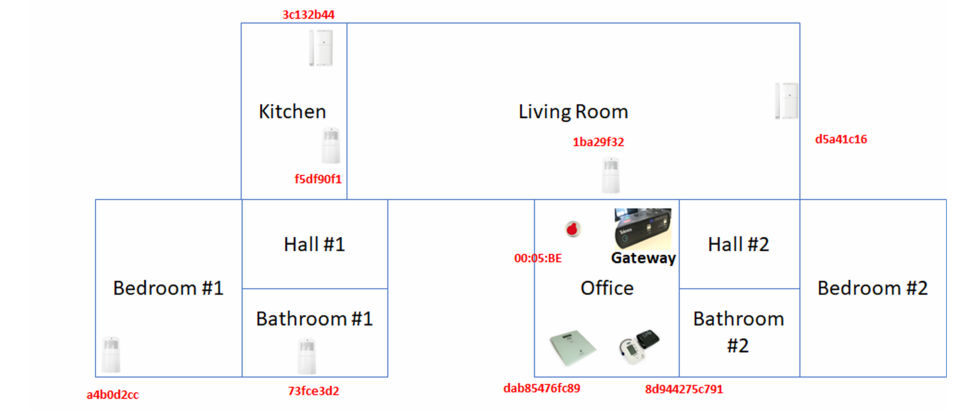
Figure 7. Plan of the smart-home